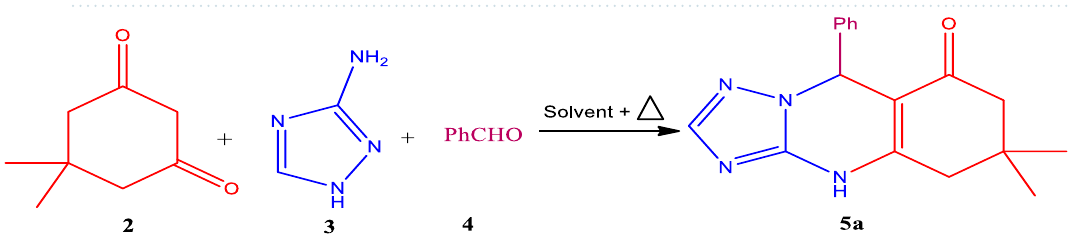
Table 1. Optimization of the conditions for the model reaction.